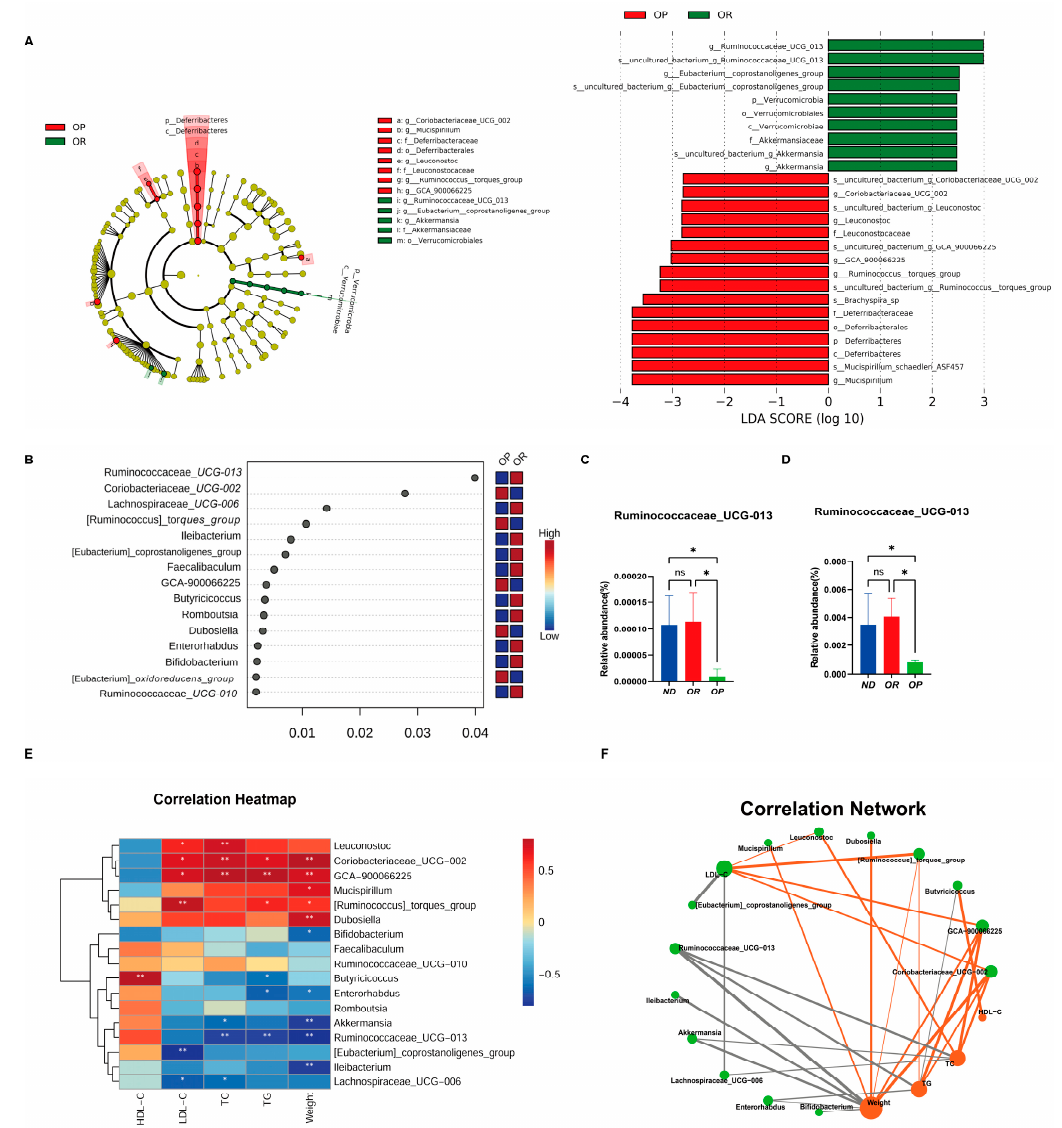
Figure 3. The specific gut microbiota linked to the development of obesity according to the machine learning algorithm. ( A ) Linear discriminant analysis (LDA) effect size (LEfSe) analyses identified bacterial biomarkers of OP and OR mice (LDA > 2, p < 0.05). ( B ) Ranking of species importance produced by random forest analyses. ( C ) The relative abundance of Ruminococcaceae_UCG-013 in different groups at week 8. ( D ) The relative abundance of Ruminococcaceae_UCG-013 in different groups at week 16. ( E ) Heatmap of Spearman’s correlation between the faecal microbiota with significant differences and serum biochemical parameters and body weight. An indicator of the degree of association is the intensity of the colour. ( F ) Co-occurrence network. Note: p < 0.05, confidence interval = 95%; green nodes are gut microbial genera; orange nodes are serum biochemical indicators; orange and black lines represent positive and negative correlations, respectively. In addition, the width of the lines indicates the strength of the correlation. * p < 0.05. ** p < 0.01. ns , not